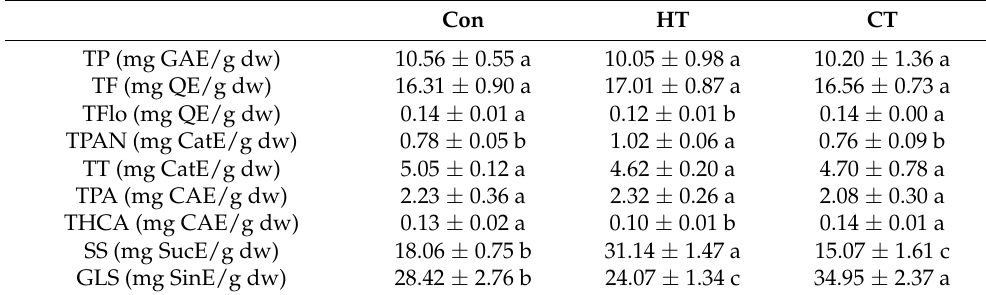
Table 1. Effects of hot- and cold-water stress on different groups of phenolic compounds, soluble sugars and glucosinolates in